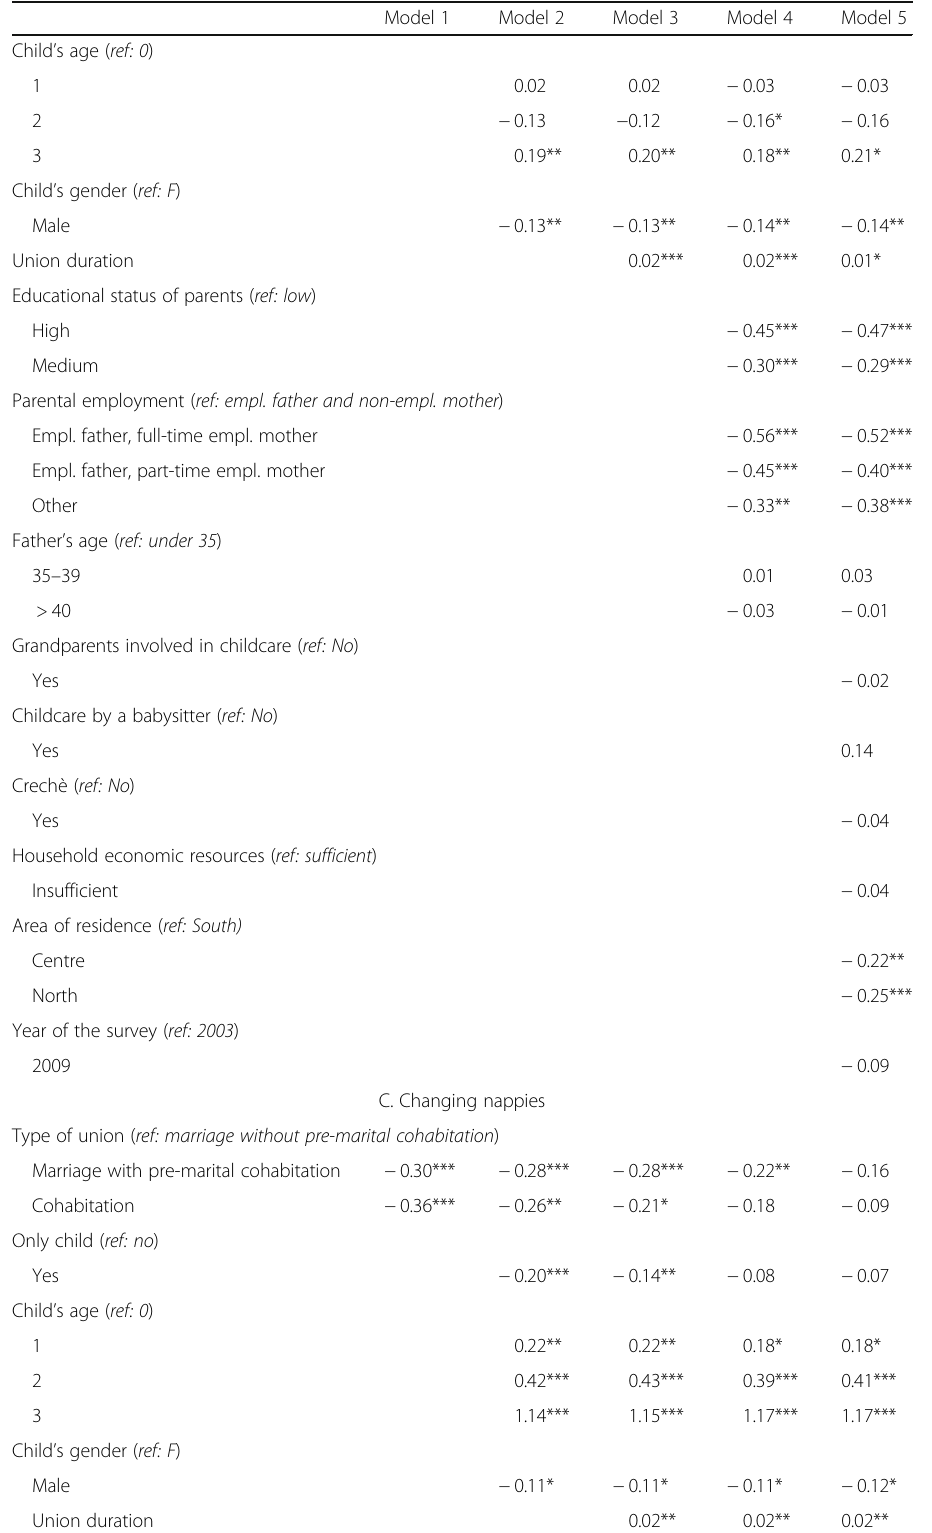
Table 3 Ordinal logistic models for fathers ’ involvement in some childcare activities — β coefficients (coefficients predicting lower involvement of fathers — 3093 observations).